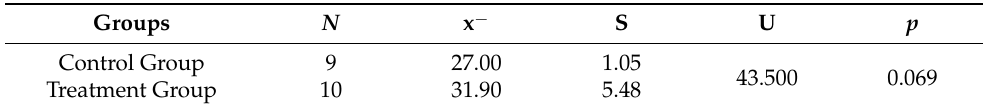
Table 5. Results Regarding the Comparison of Cause-Effect Relationship Scale Pre-Test Scores of the Control and Treatment Group Students.